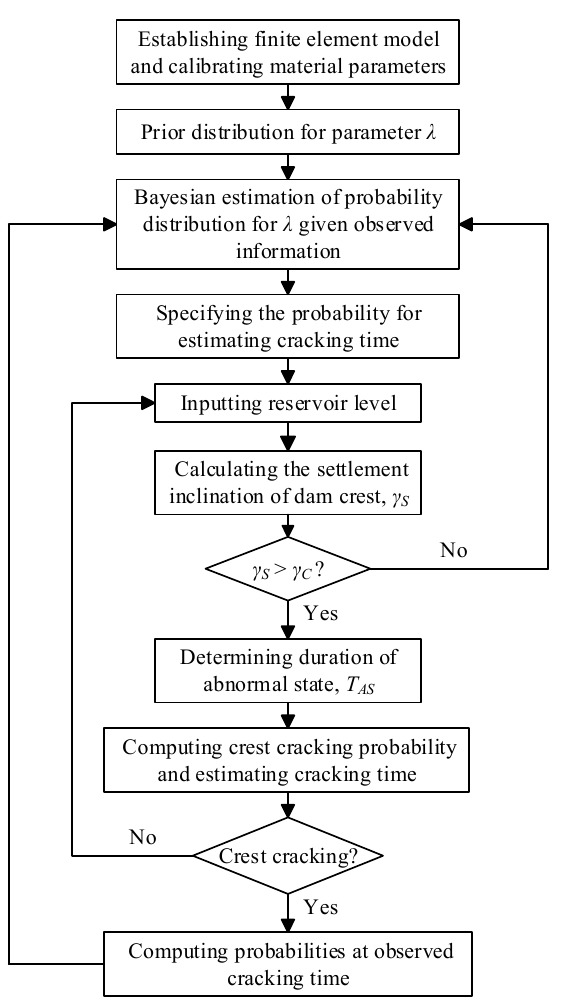
Figure 5. Flowchart of the methodology for dynamic risk evaluation and early warning of crest cracking.